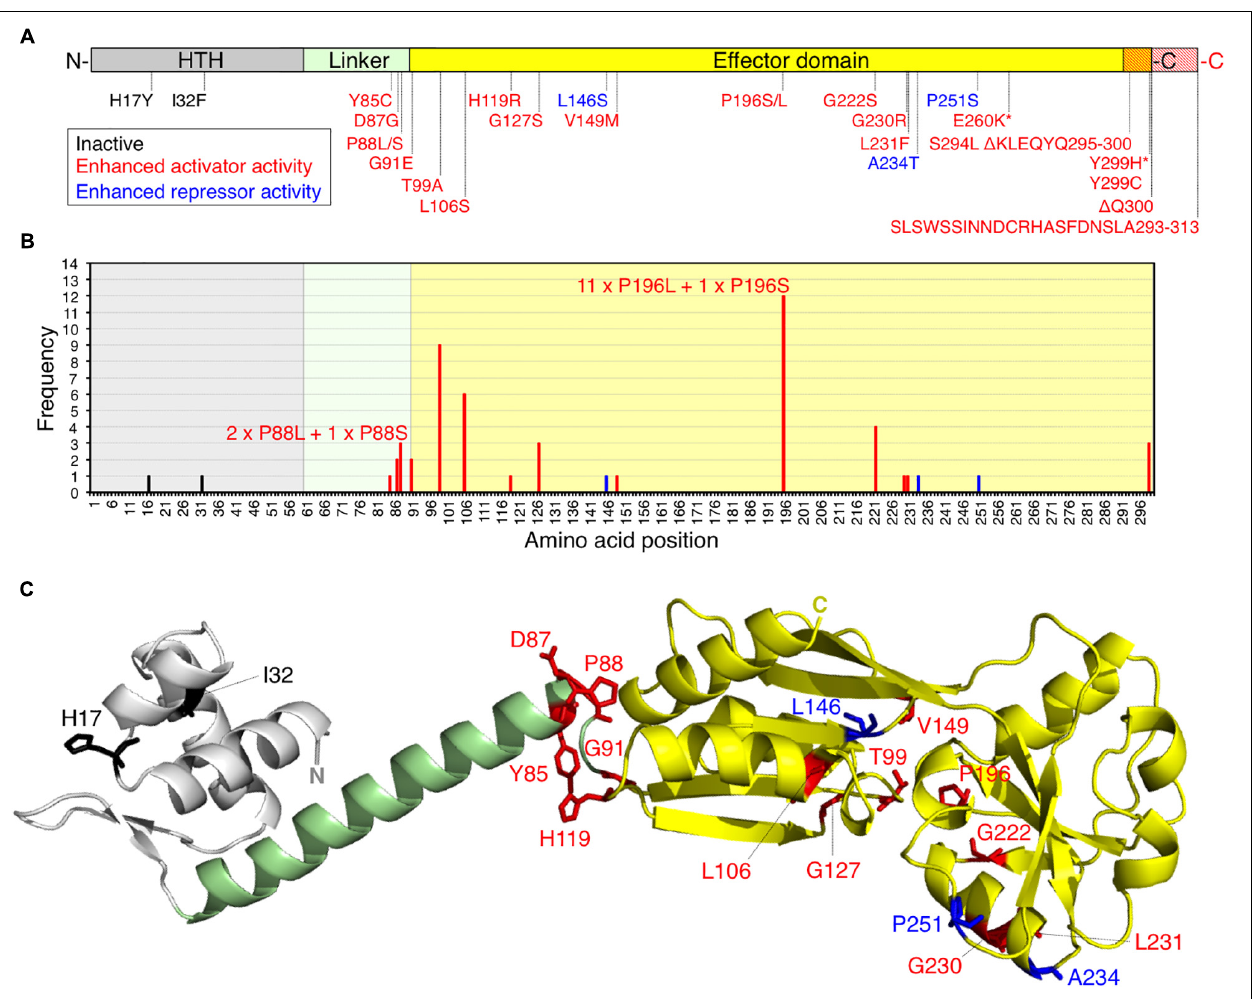
FIGURE 3 | (A) Amino acid replacements in GltC that affect the DNA-binding activity of the regulator. The asterisks indicate that the amino acid replacements E260K and Y299H occurred simultaneously in one GltC variant. (B) Frequency of the amino acid replacements in GltC. The GltC E260K Y299H variant, the truncated as well as the elongated GltC variants appeared only once and are not included in the graph. (C) Localization of the amino acid exchanges that affect the DNA-binding of GltC in a full-length model of the protein. Coloring of the GltC monomer model corresponds to that used for illustrating the domain organization of the regulator in (A) . The model was generated using the SWISS-MODEL server for homology modeling of protein structures (Waterhouse et al., 2018) and a model of the tetramer structure of the CbnR LysR-type regulator from Cupriavidus necator (PDBid: 1lZ1) (Muraoka et al., 2003). The overall amino acid sequence identity between GltC and CbnR is 28%. HTH, helix-turn-helix